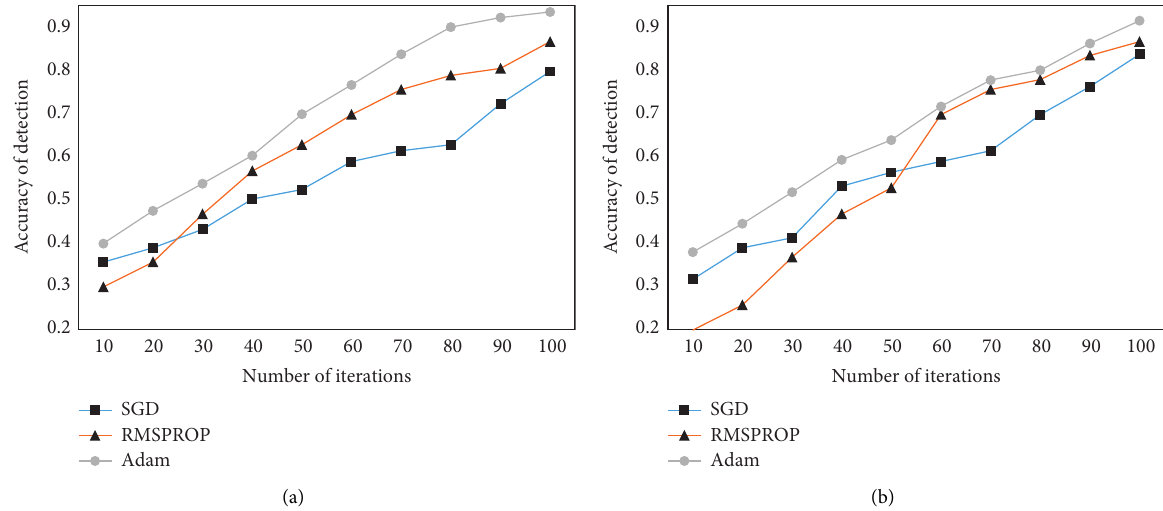
Figure 8: The relationship between optimizer and recognition rate. (a) Accuracy in HMDB51 dataset. (b) Accuracy in UCF-101 dataset.